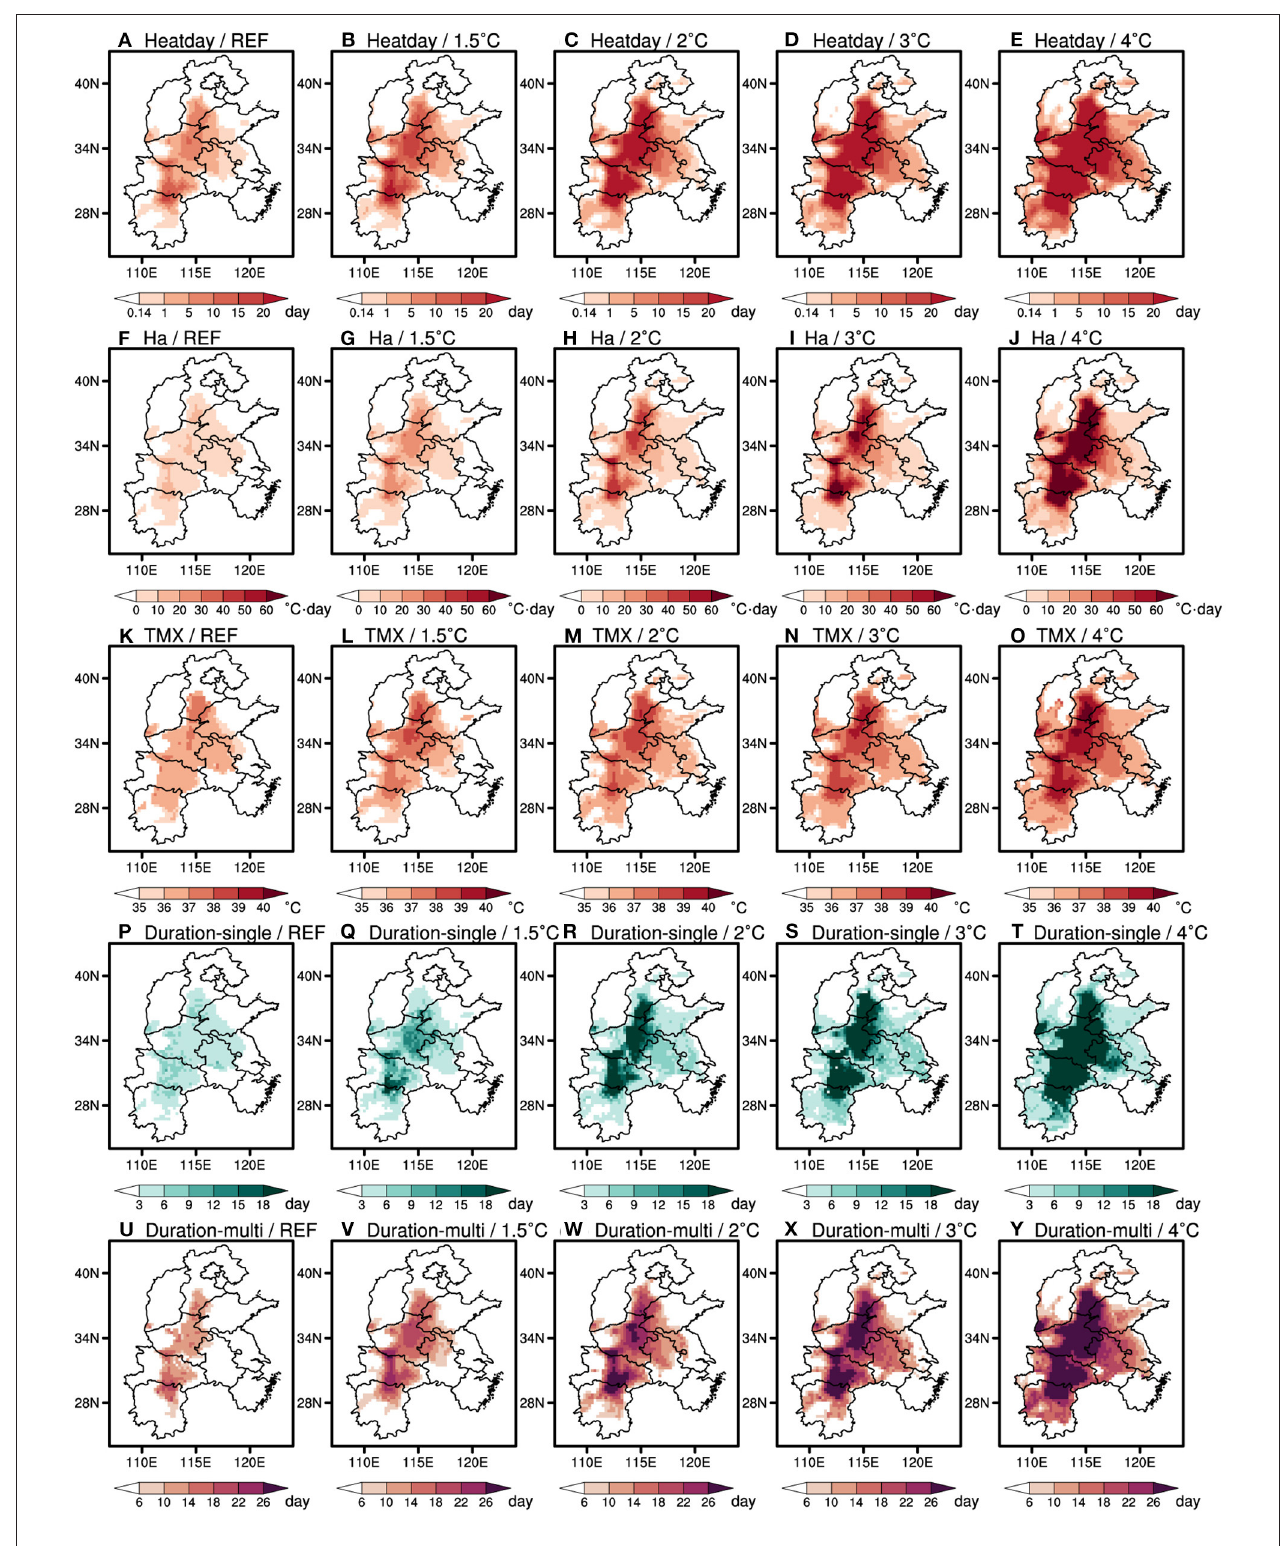
FIGURE 6 | Same as Figure 4 but for Central and East